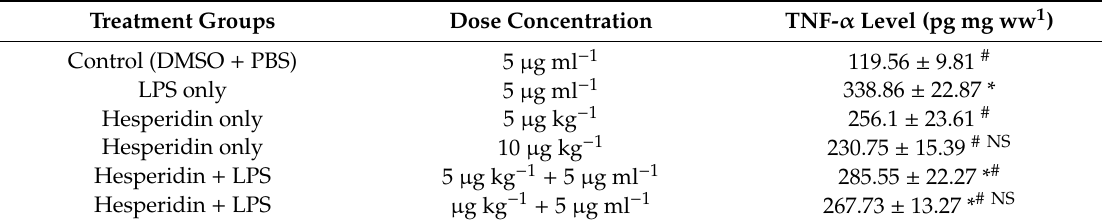
Table 2. TNF- α level in spleen homogenate of mice injected hesperidin for five days and treated with or without LPS. Experiment was performed in